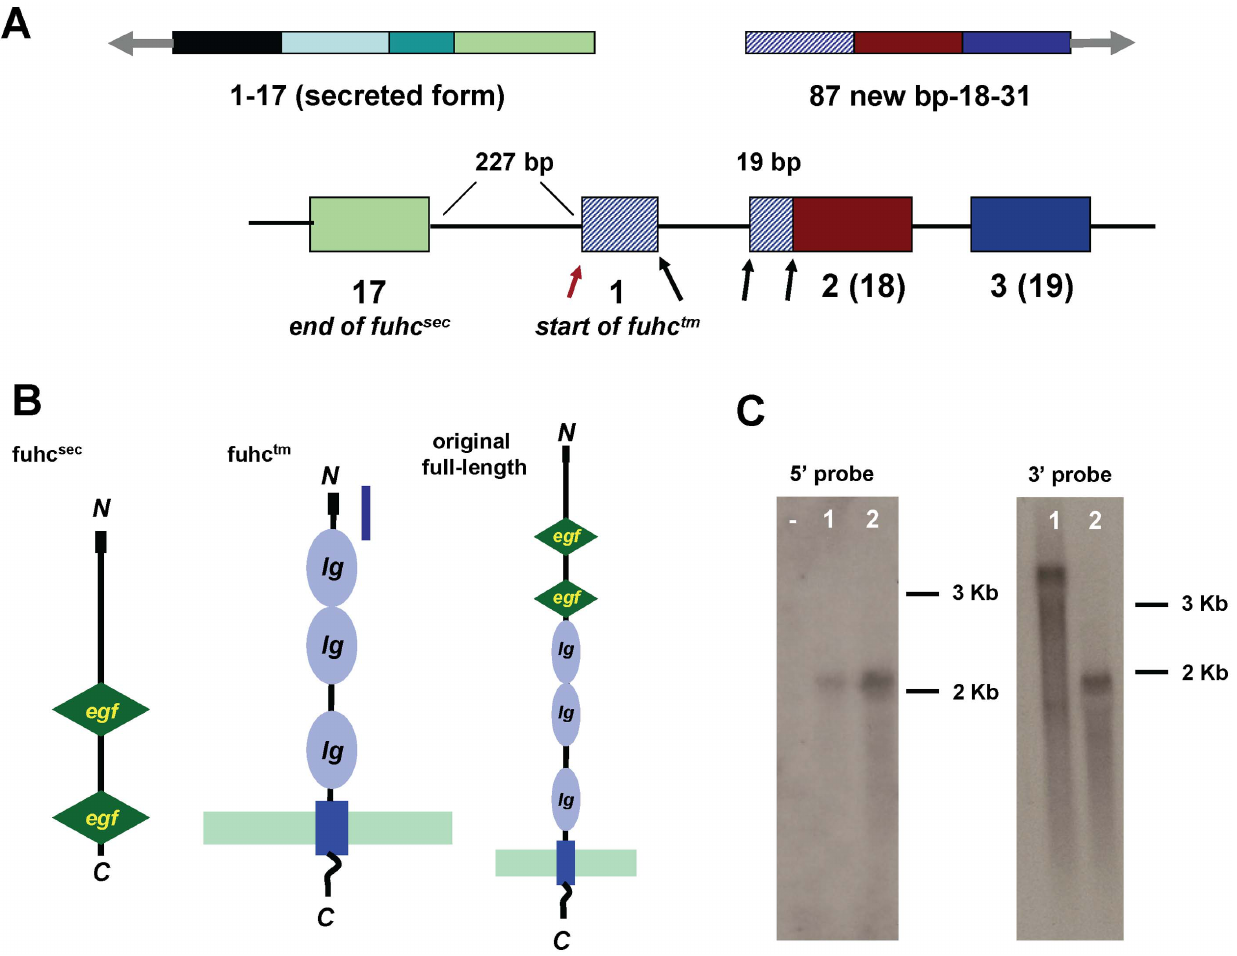
Figure 2. the candidate fuhc encodes two tightly linked genes. A. Schematic of the region between fuhc sec and fuhc tm . The new 86 bp region is shown in hatched bars, and encodes a new start codon, and a portion of exon 2 of the tm form (exon number in parentheses are the original exon designation). Black arrows show correct intron/exon boundaries, the red arrow outlines the start of the first exon of fuhc tm , which does not have the correct intron/exon boundary sequence. B. Illustration of the structure of fuhc sec (left) and fuhc tm (center) and original full-length protein (right) as predicted by ELM (17). The blue line on fuhc tm (center) represents the new coding sequence C. Northern blot of total RNA hybridized with probes specific for fuhc sec (left) and fuhc tm (rt). Left: lanes 1 and 2 are RNA isolated from two wild-type genotypes, – indicates no RNA. Right. Lane 1 is a positive control using RNA isolated from 293T cells expressing a construct encoding exons 1–27 of the original full-length fuhc /EGFP fusion protein (expressed in Figure 1D). Lane 2 is a separate